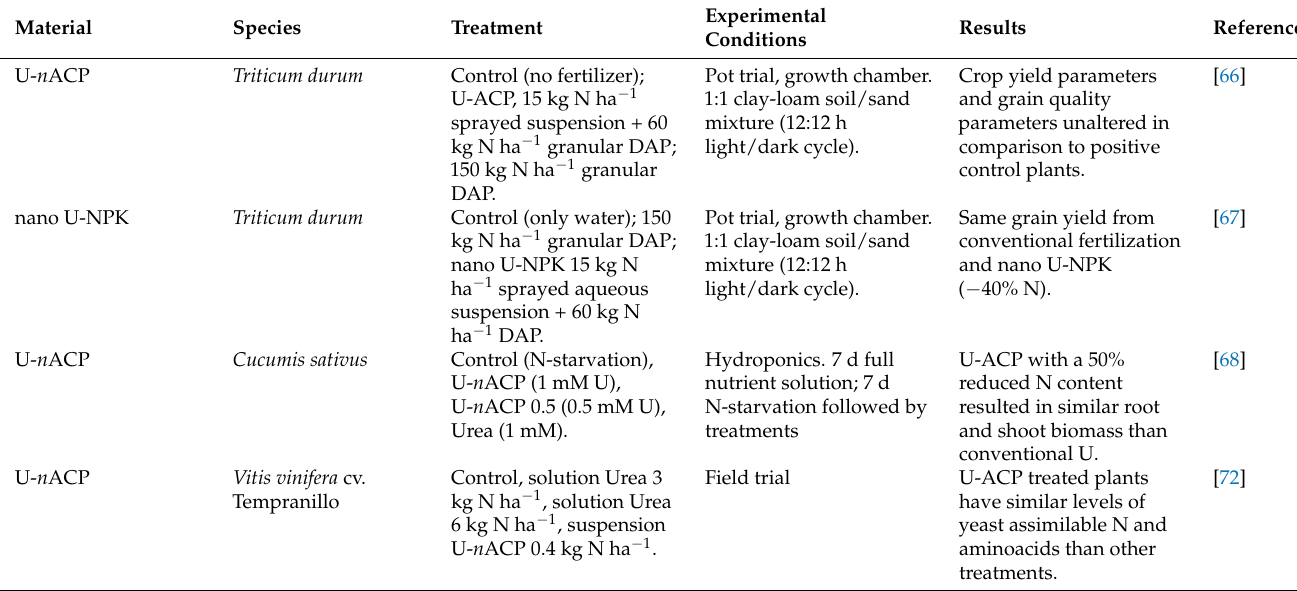
Table 4. Amorphous calcium phosphate nanoparticles as nanofertilizers.